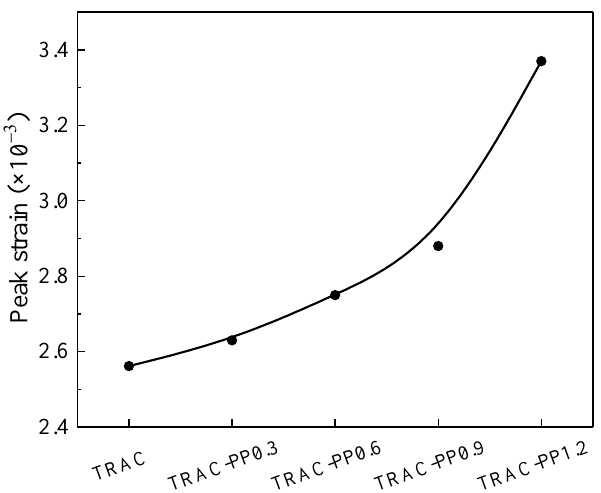
Figure 6. Effect of PPF content on the peak strain of